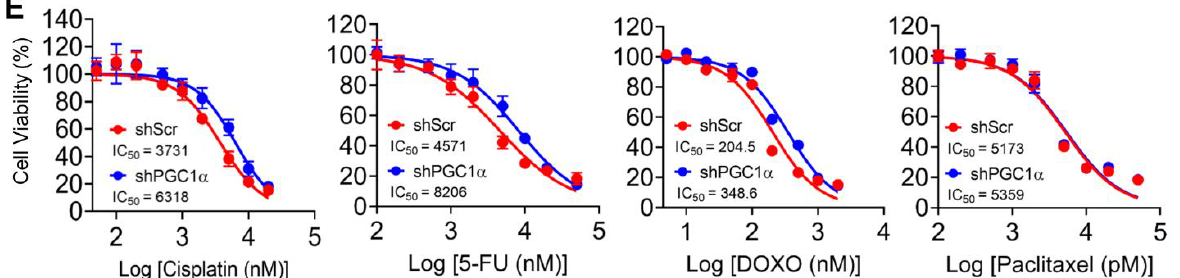
Figure 2. PGC1 α loss promotes tumor initiation and lung cancer metastasis to bone. ( A ) Migrated and invaded cells in control and PGC1 α -silenced A549 and H358 cells ( n = 5). Scale bar represents 200 µ m. High Resolution Images are showed in Figure S8. ( B , C ) Luciferase images from control or PGC1α-silenced A549 cells xenografted mice ( n = 5) by intratracheal ( B ) and tail-vein ( C ) injection. Luciferase images represent one picture captured and the values of photons emission are represented as mean ± SEM of the indicated number of mice. * p < 0.05 by Student’s t -test. ( D ) In the serial dilution xenograft assays, a varying number (as indicated) of the control or PGC1 α knocked-down A549 cells were transplanted in BALB/c-nude mice by subcutaneous (S.C.) injection and incubated for 4 weeks. ( E ) Cell viability analysis after the control or the PGC1 α -silenced A549 cells were treated with cisplatin, 5-fluoruracil (5-FU), doxorubicin, and paclitaxel at different concentrations, as indicated, for 3 days. Values represent mean ± SD ( n = 3). * p < 0.05 and *** p < 0.001 by Student’s t -test.